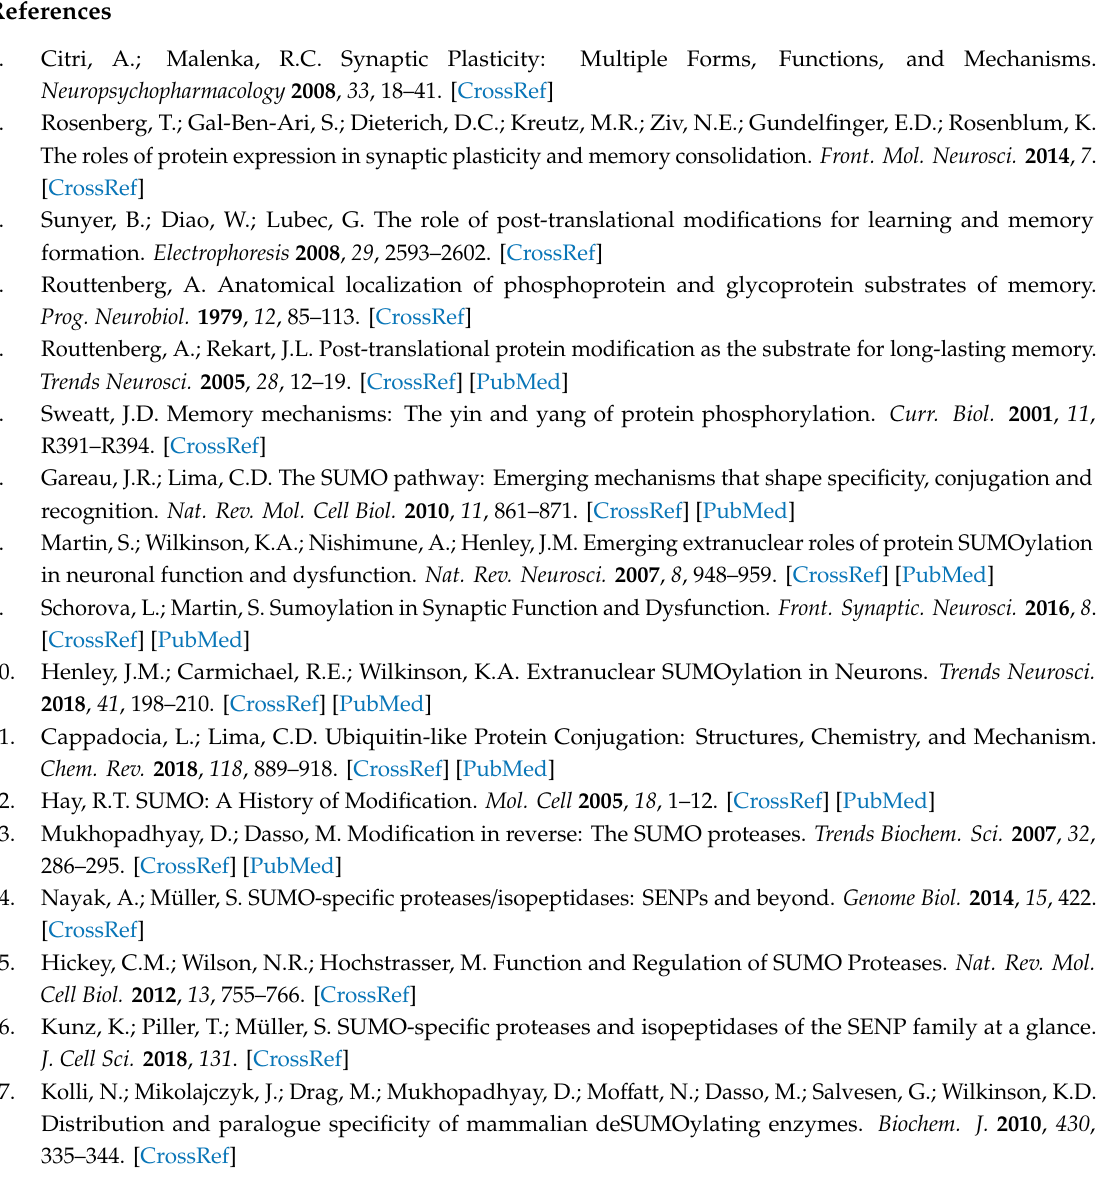
Figure S1: SIM microscopy to determine the neuronal localization of SENP1 using a second antibody (OriGene, TA800001). Figure S2: SIM microscopy to determine the neuronal localization of SENP6 using a second antibody (Novus Biologicals, H00026054-M01). Figure S3: SIM microscopy to determine the neuronal localization of SENP7 using a second antibody (Novus Biologicals,